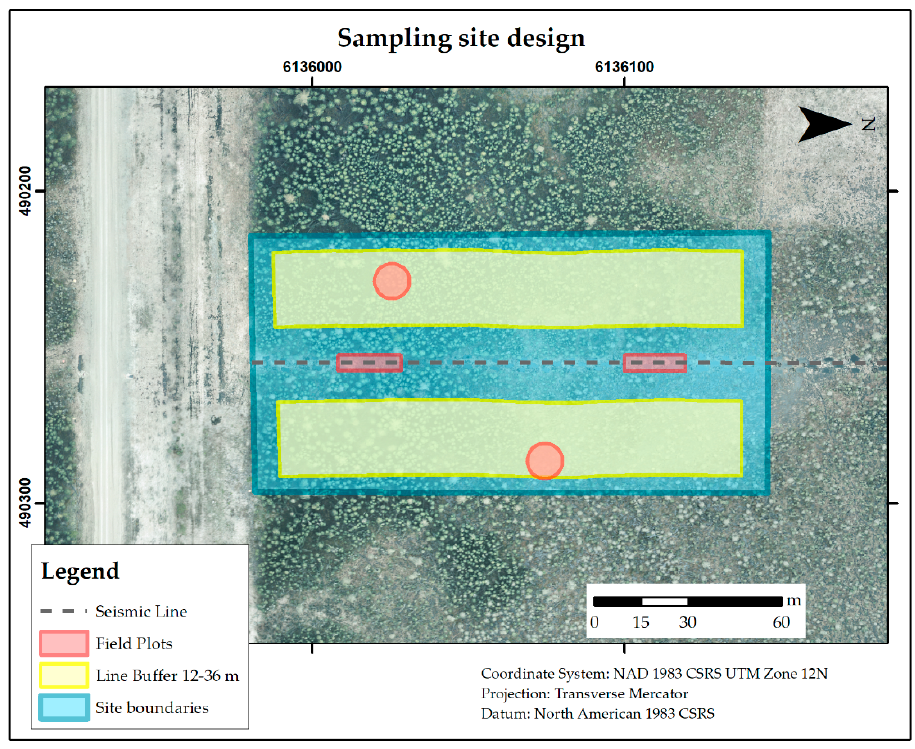
Figure A1. Examples of sampling areas for the collection of training and calibration CWD data. For each study site two (belt) disturbance plots are laid out on the seismic line and two (circle) forest plots are laid out off the seismic lines centered within a buffer from 12 to 36 meters away from the line.